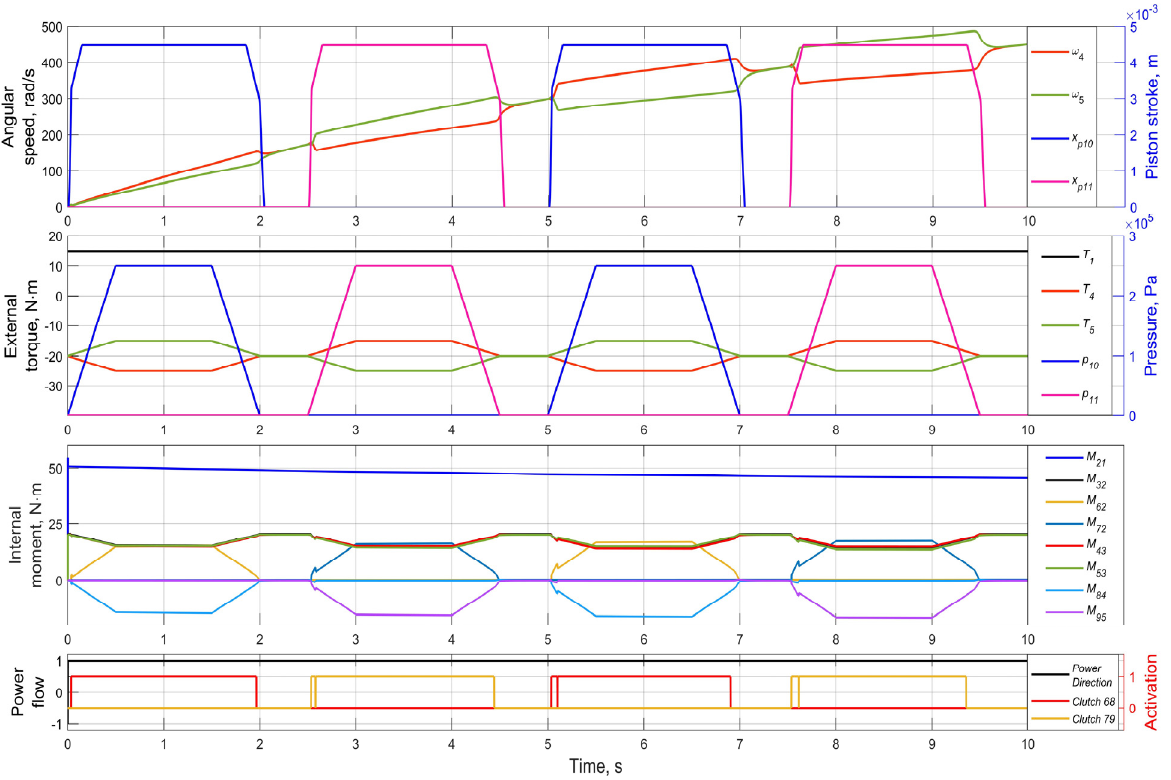
Figure 10. Simulation of alternating activation of friction